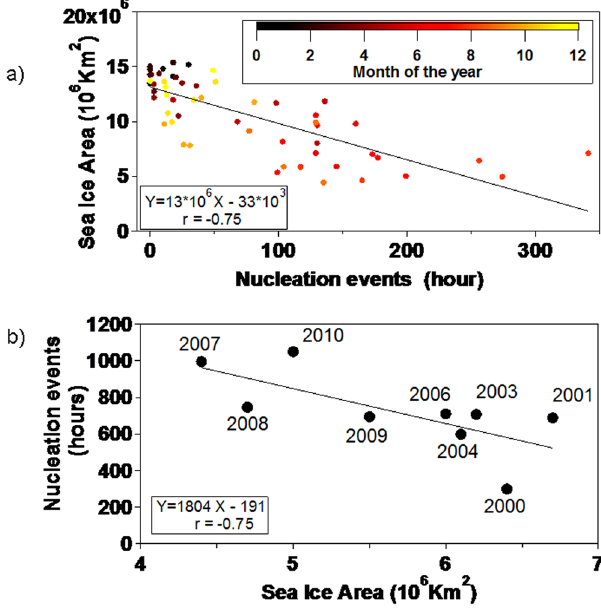
Figure 4. Relationship of sea ice extent (calculated over nearby regions of Greenland Sea and Barent Sea) with the nucleation aerosol category. Year 2002 and 2005 are not considered given low DMPS data capture 8